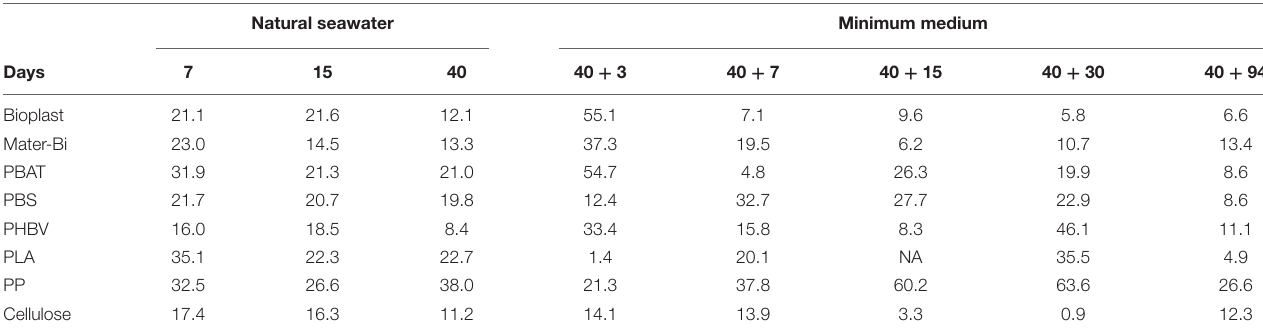
FIGURE 4 | Evolution of the major OTUs ( > 4%) on the different materials according to the date of incubation in seawater for 40 days (D40) and in minimum medium for 94 days (D40 + 94). OTUs, operational taxonomic units. TABLE 2 | Percentage of OTU selected as putative HCB on each material (PP, PLA, PBS, PBAT, Mater-Bi, Bioplast, PHBV, and cellulose) according to the date of incubation in seawater during 7, 15, and 40 days (D40) followed by the transfer in minimum medium during 3 (40 + 3), 7 (40 + 7), 15 (40 + 15), 30 (40 + 30), and 94 days (40 +